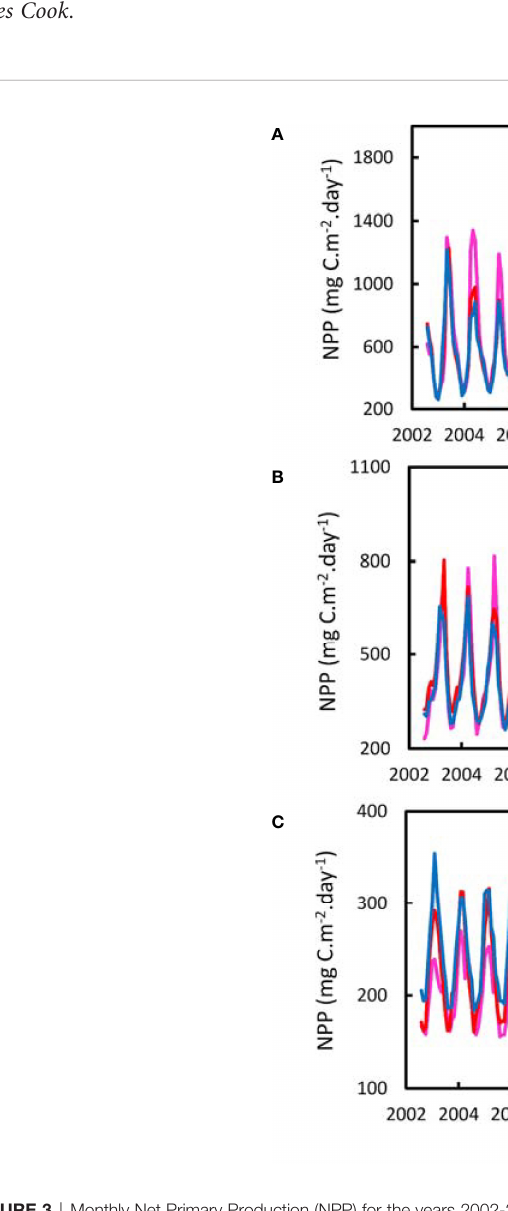
FIGURE 3 | Monthly Net Primary Production (NPP) for the years 2002-2020. (A) Northern Stratum 40°-48°N, (B) Azores Stratum 32.5°-40°N, (C) Southern Stratum 10°-32.5°N. Red line - MAR Polygon, Pink line – West Polygon. Blue line - East